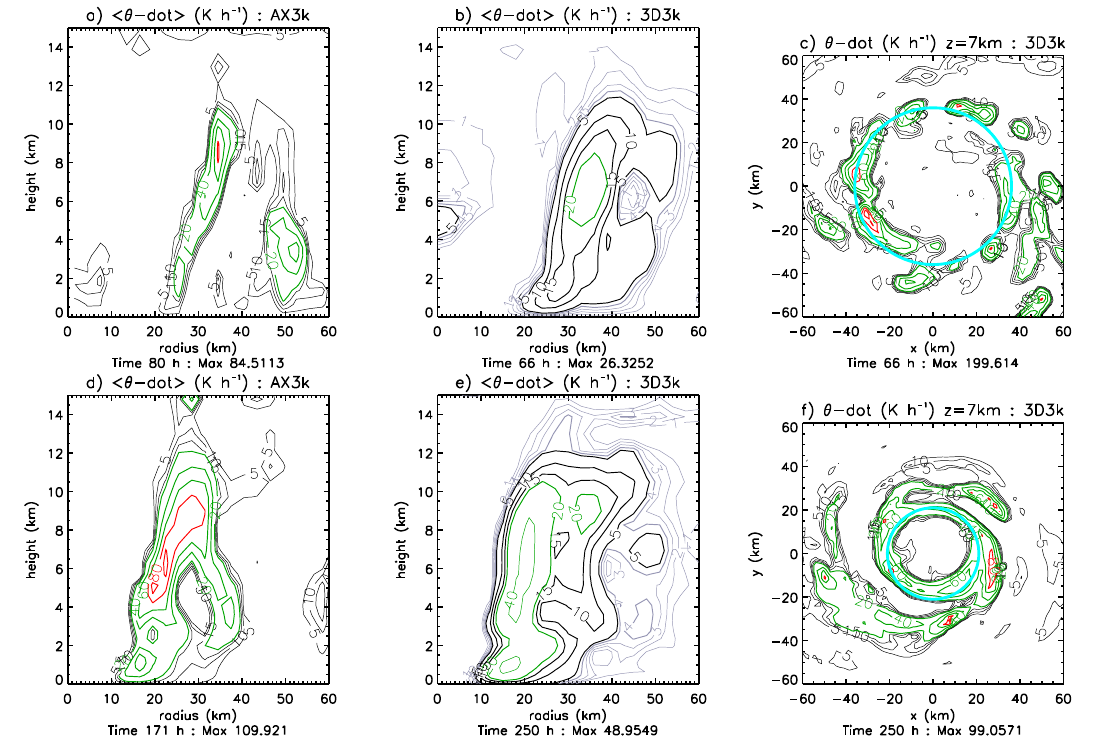
Fig. 5. Diagnosed heating rates during the periods of peak intensification and maximum quasi-steady intensity. Panels a and b are radius- height cross sections of the axisymmetric mean heating rate from the AX3k and 3D3k simulations, respectively, at a time of rapid intensification; panels d and e present, respectively, the same at a time of maximum intensity. Panels c and f are plan-view plots of heating rate at z = 7 km from the 3D3k simulation during intensification and maximum intensity; the blue circle depicts the radius of maximum heating rate at this height. Thin, black contours are 5, 10, and 15 K h − 1 . Thick, green contours are 20, 40, and 60 K h − 1 . Thick, red contours are 80 and 100 K h − 1 .